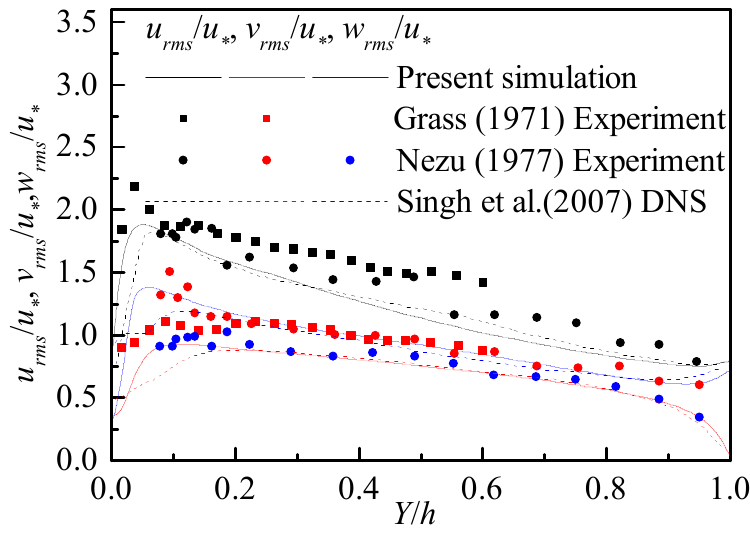
Figure 4. Turbulence quantities [45,57,58].